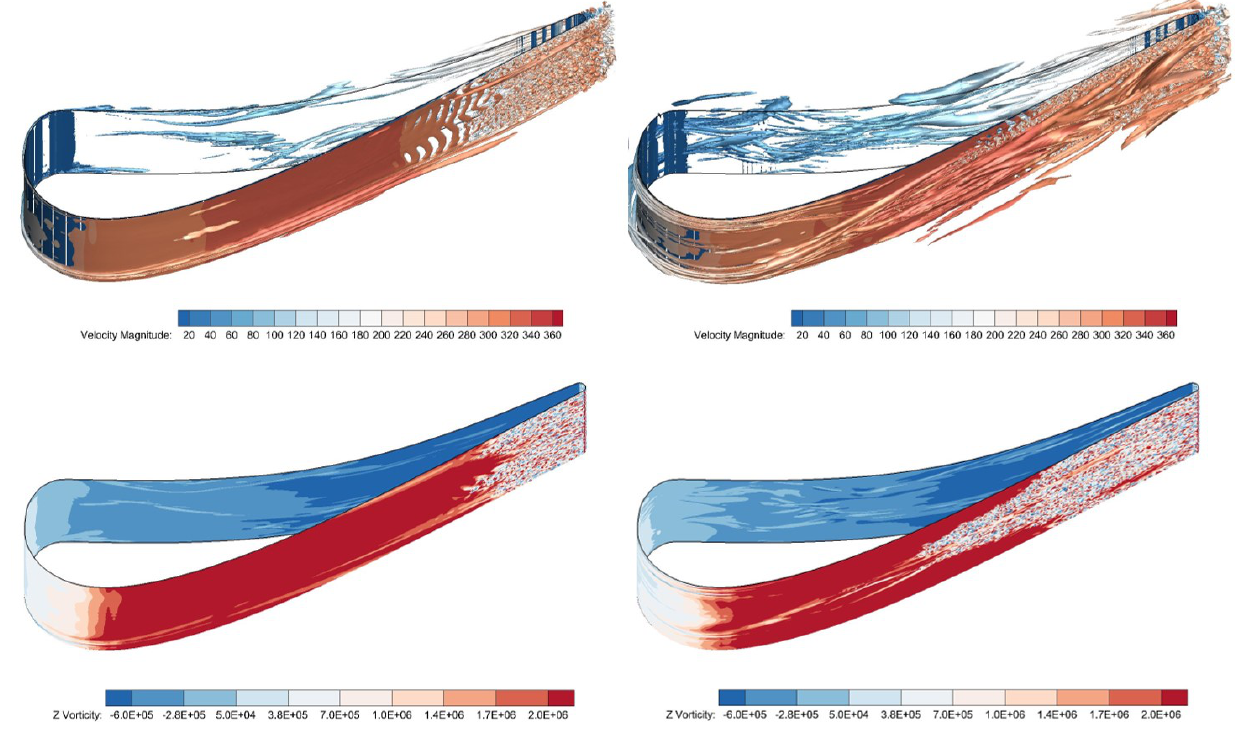
Figure 6. Interaction of the incoming turbulent eddies with the boundary layer for the 3 mm and 5 mm cases: isosurfaces of Q = 1 × 10 8 colored by velocity magnitude ( top ) and the contour of spanwise vorticity at 1 × 10 − 5 mm from the blade surface ( bottom